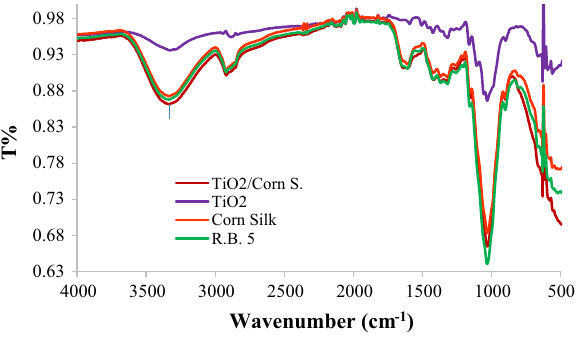
Fig. 3 FT-IR spectra of the CS; TiO TiO